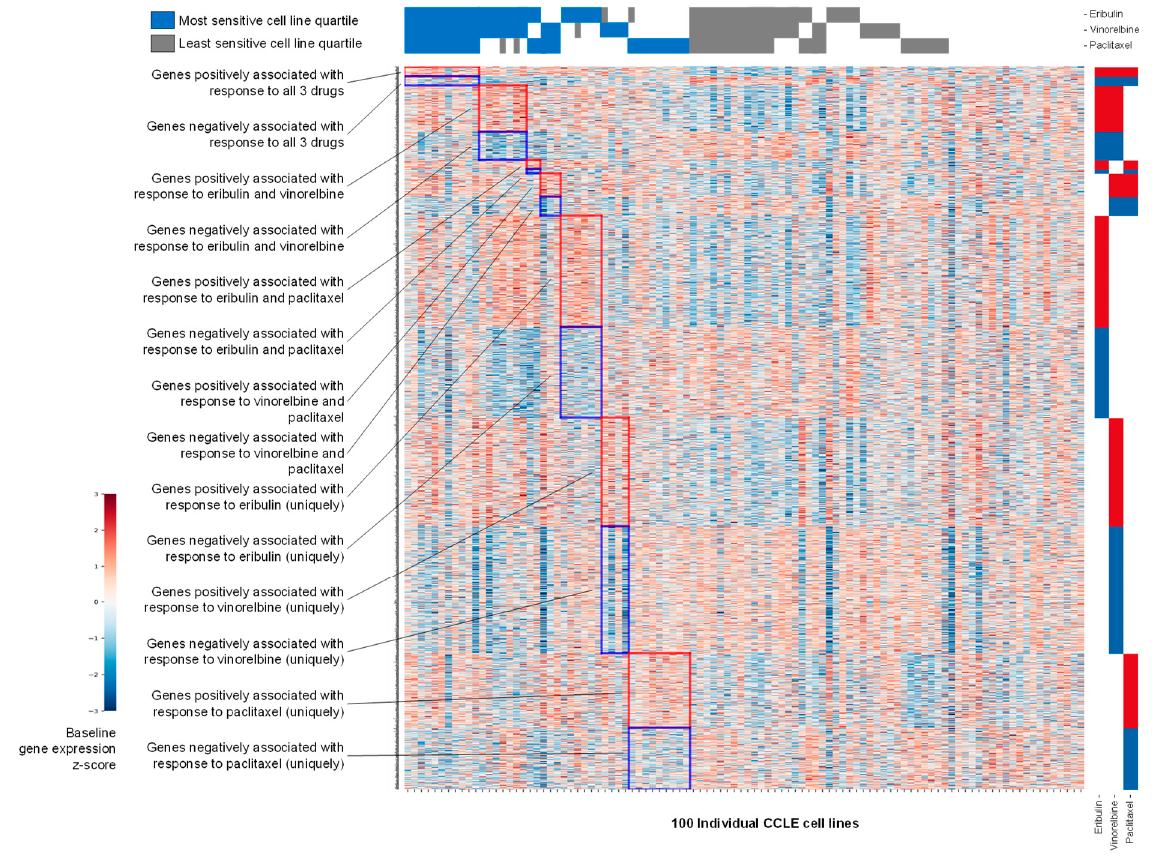
Figure 2. Z-score heat map showing baseline gene expression across 100 CCLE cell lines. Genes shown (rows) are those positively or negatively associated at p < 0.05 with the most sensitive versus least sensitive cell line quartiles for eribulin, vinorelbine and paclitaxel as indicated across the top of the heat map. The left and right sides of the y -axis show textual or visual representations of associations of genes with 1, 2 or all 3 of the tested drugs.